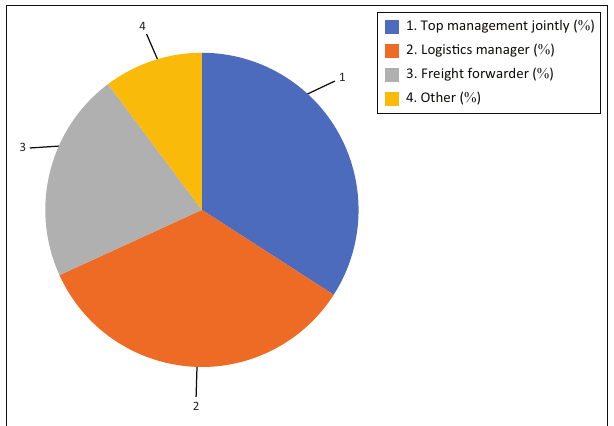
FIGURE 1: Decision-maker in the